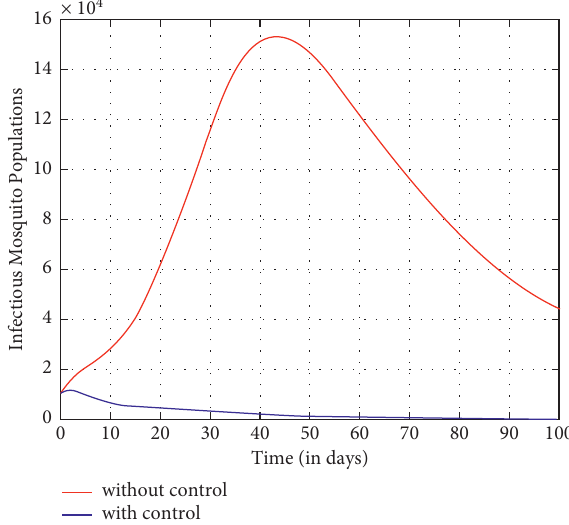
Figure 19: Infectious mosquito population with and without control variable u .